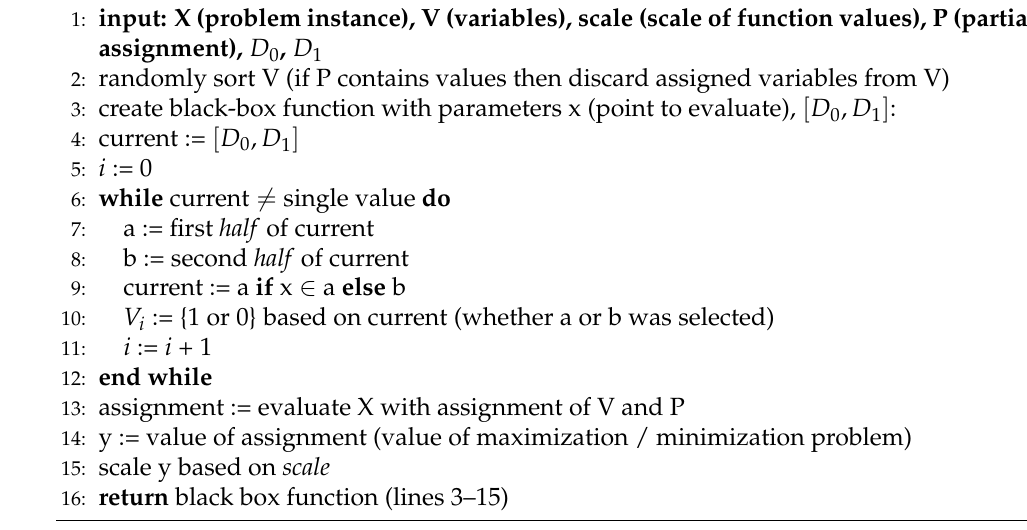
Algorithm 1 Combinatorial problem to finite domain univariate